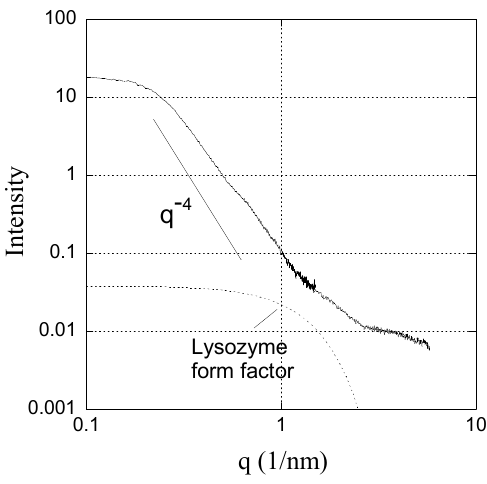
Figure 7. Synchrotron SAXS data for the shell formed by lysozyme in a PSS macrogel ( β = 0.55). The form factor of lysozyme [57] is included for reference.